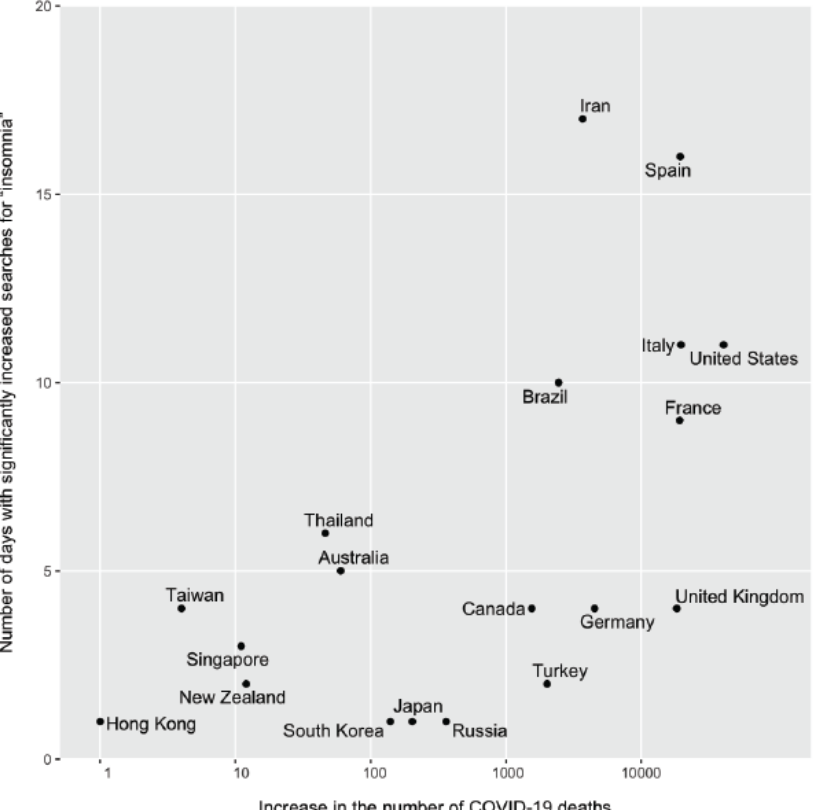
Figure 3. Positive correlation between increases in COVID-19–related deaths and the number of days with an increase in searches for insomnia in